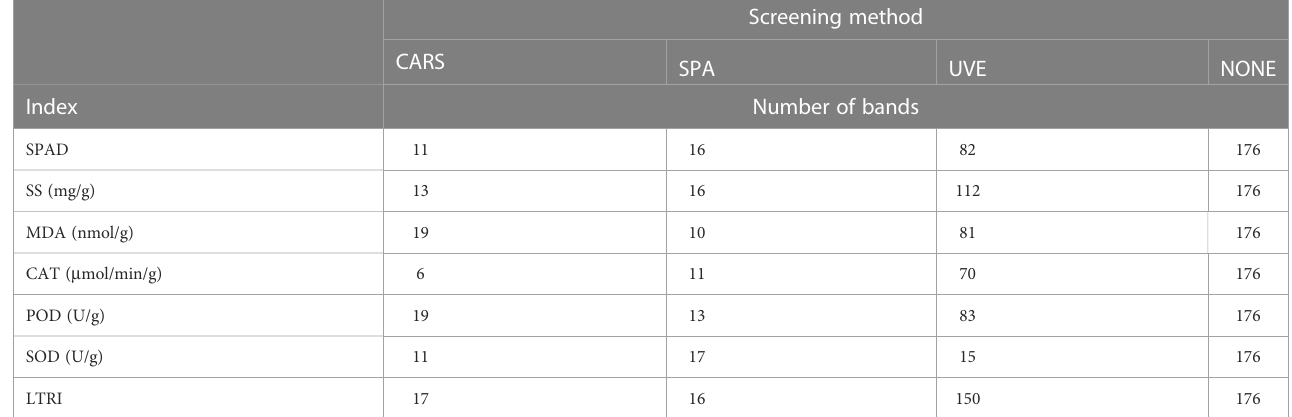
TABLE 7 Bands screening result.